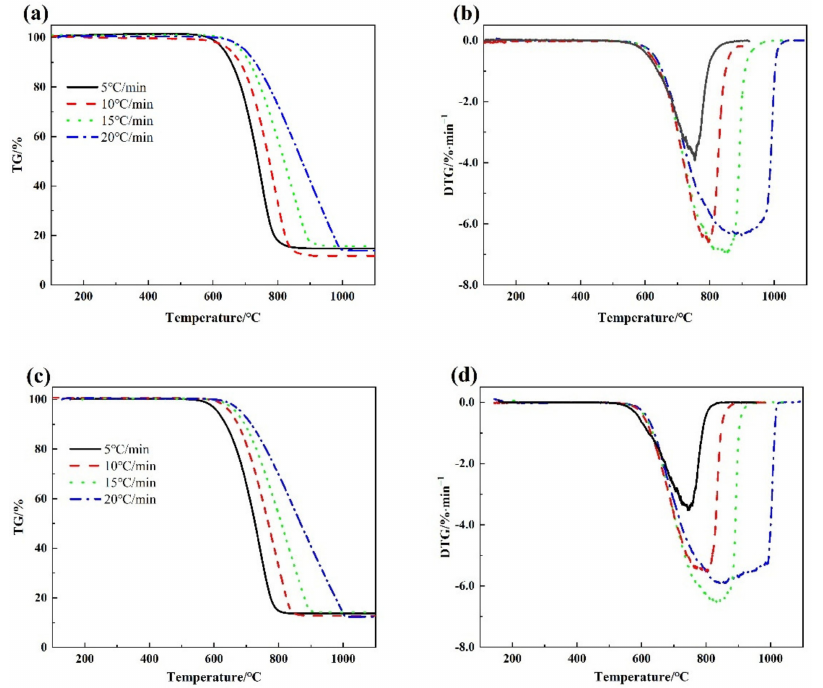
Figure 2. TG-DTG curves of metallurgical coke combustion with different reactivity ( a ) is the TG curve of the L-Coke, ( b ) is the DTG curve of the L-Coke, ( c ) is the TG curve of the H-Coke ( d ) is the DTG curve of the H-Coke.